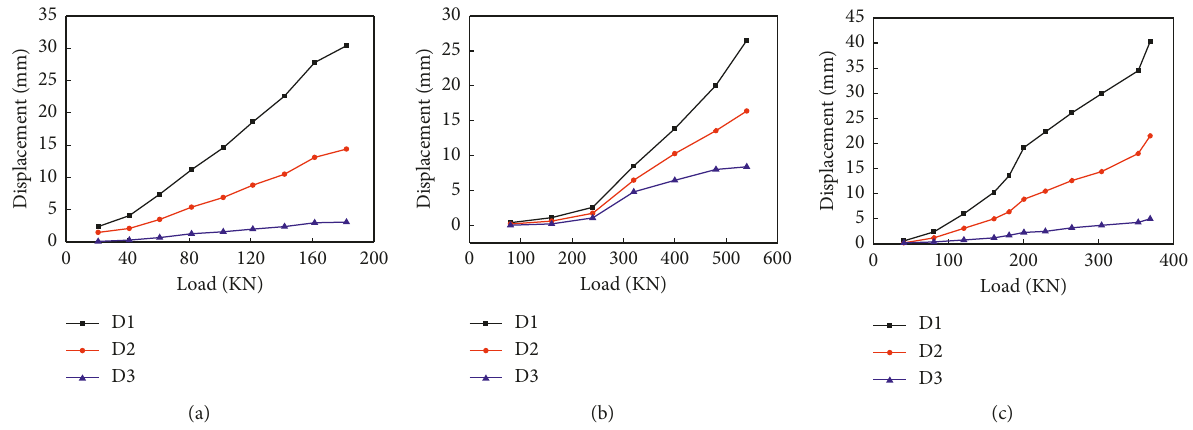
Figure 15: Displacement of the frame columns at different heights: (a) UWF, (b) TMWF, and (c)